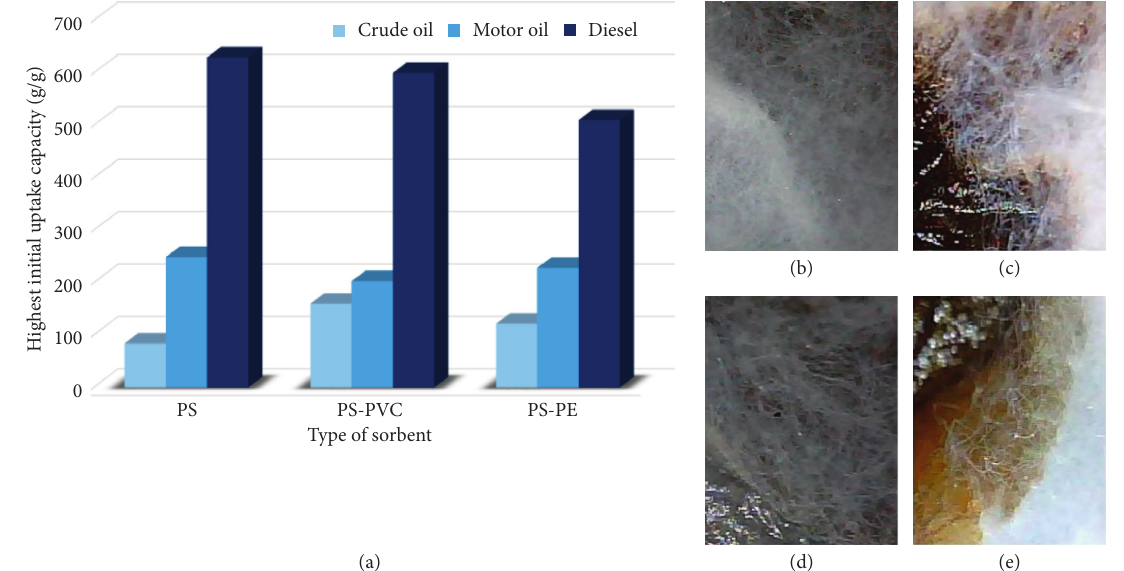
Figure 7: (a) Highest uptake capacity of PS-PE and PS-PVC fibrous sorbents to crude oil, motor oil, and diesel spills. Optical images of PS fibrous sorbents (b) as prepared, (c) after crude oil spill sorption, (d) after diesel spill sorption, and (e) after motor oil spill